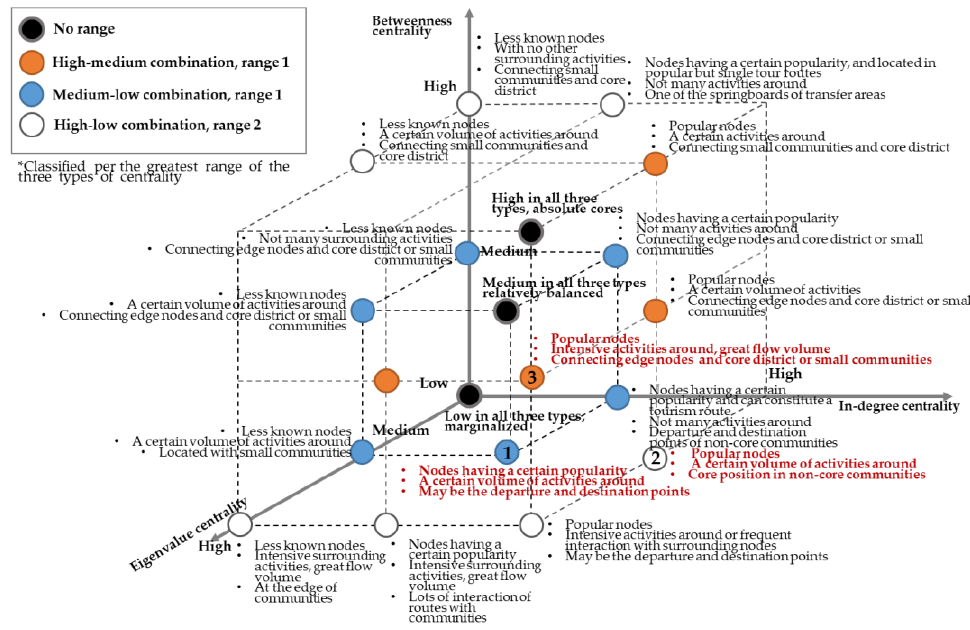
Figure 8. Node status evaluation system for tourism flow networks.